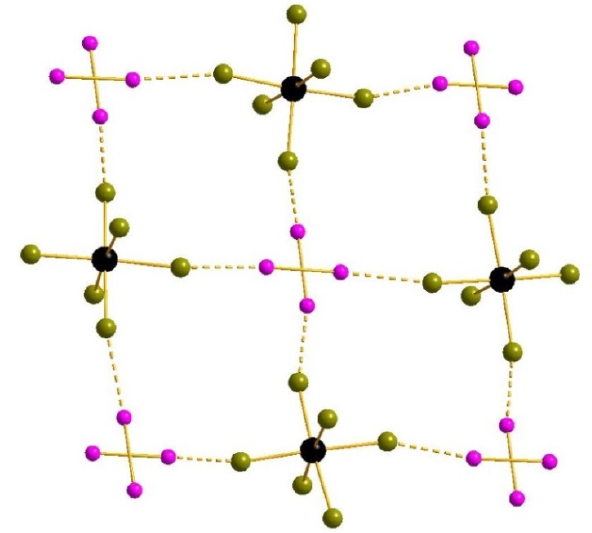
Figure 1. Supramolecular associates built of [SnBr 6 ] 2 − and I 2 units in the structure of 1 . Here and below: Sn black, Br olive-green, I purple, I ··· Br interactions dashed. All positions of disordered I 2 fragments are shown.